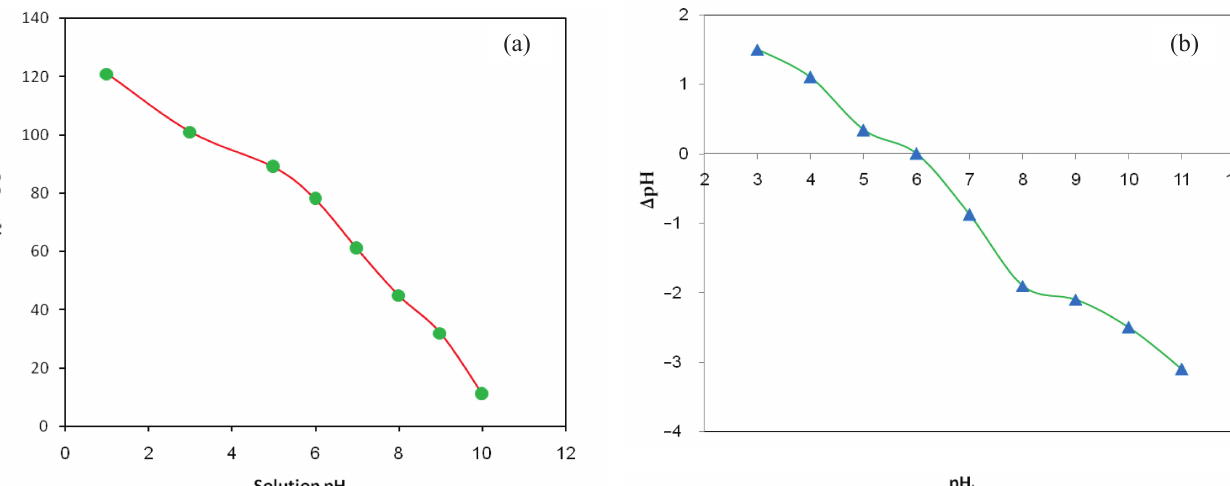
Fig. 11 – Effect of solution pH on Cr(VI) adsorption capacity of MHN adsorbent (a) and plot of ∆pH against pH bent (b)